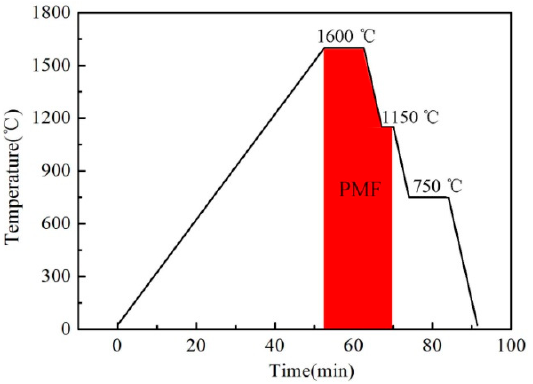
Figure 2. Schematic sketch of phase transformation stages treated with a PMF from 1600 °C to 1150 °C.